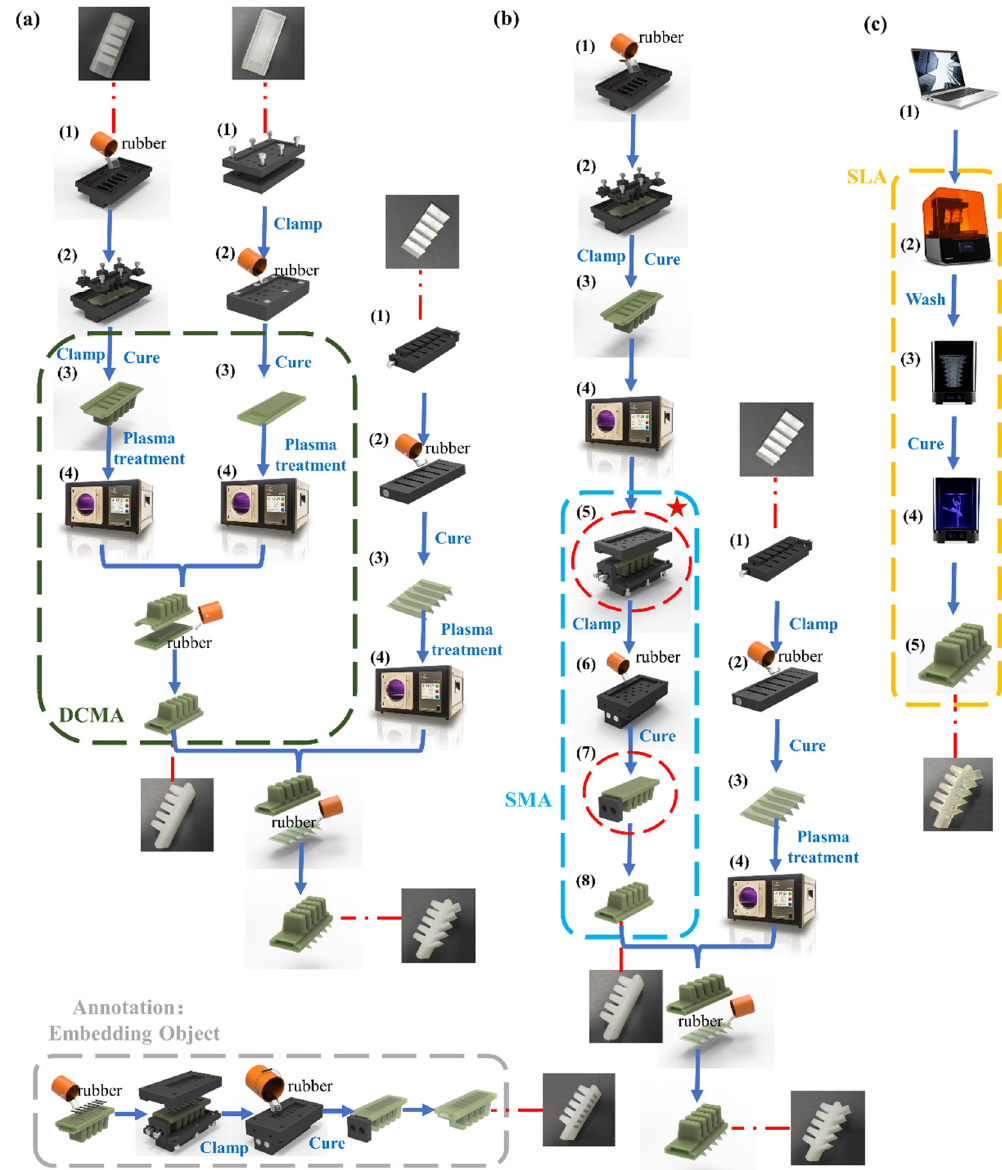
Figure 6. Three fabrication processes: ( a ) lamination mold casting (“divided cavity molding-integrated assembly,” DCMA); ( b ) optimized lamination mold casting (“simultaneous molding and assembly,” SMA); and ( c ) stereolithography (SLA) 3D printing technology.